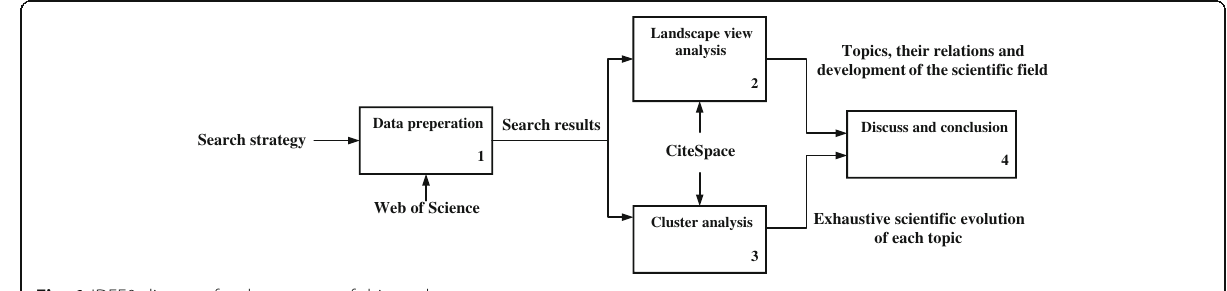
Fig. 1 IDEF0 diagram for the process of this